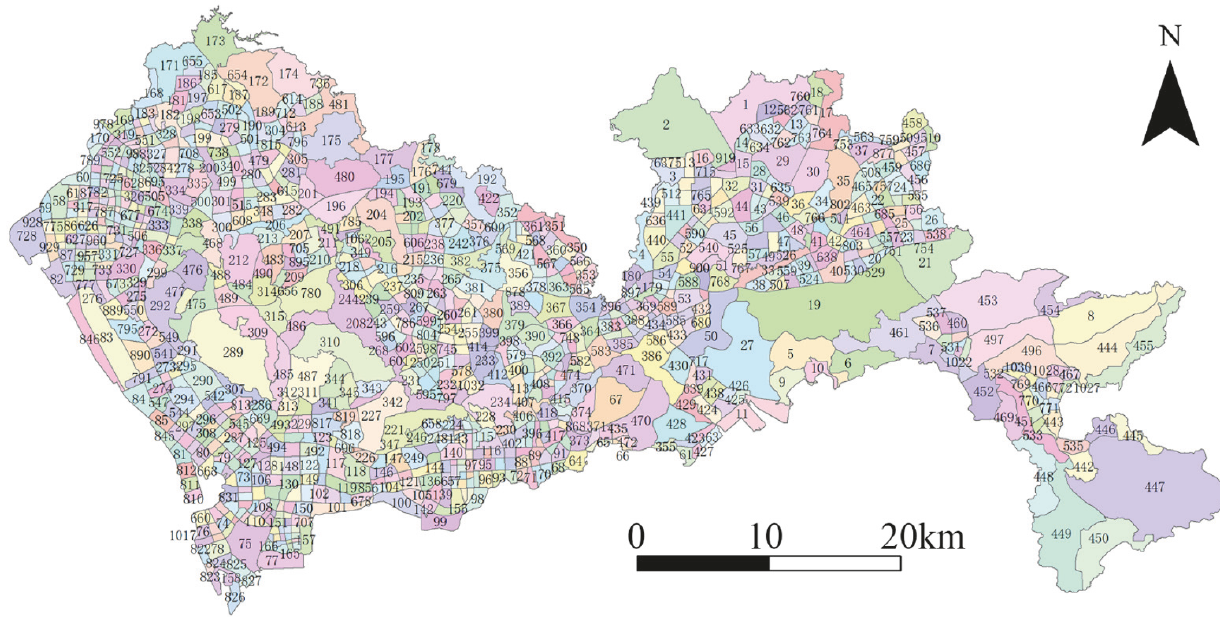
Figure 1: Traffic analysis zones in the city of Shenzhen,